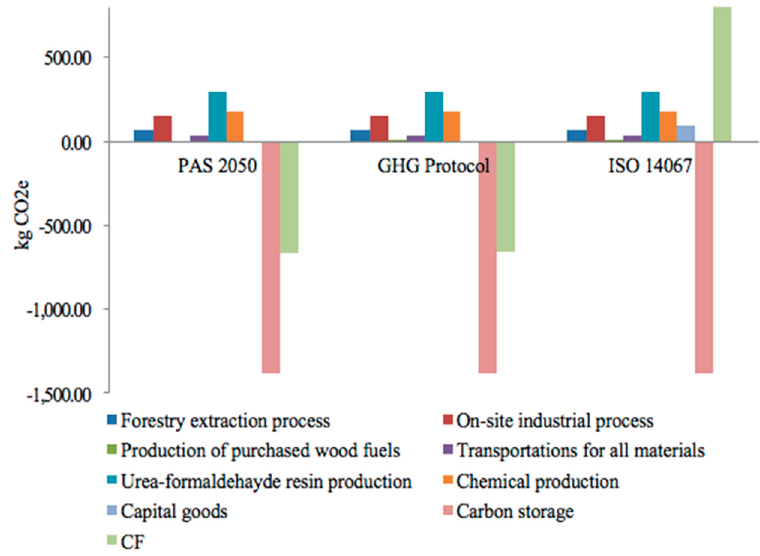
Figure 4. Cradle-to-gate life cycle carbon footprint of MDF quantified by PAS 2050, GHG Protocol, and ISO 14067.